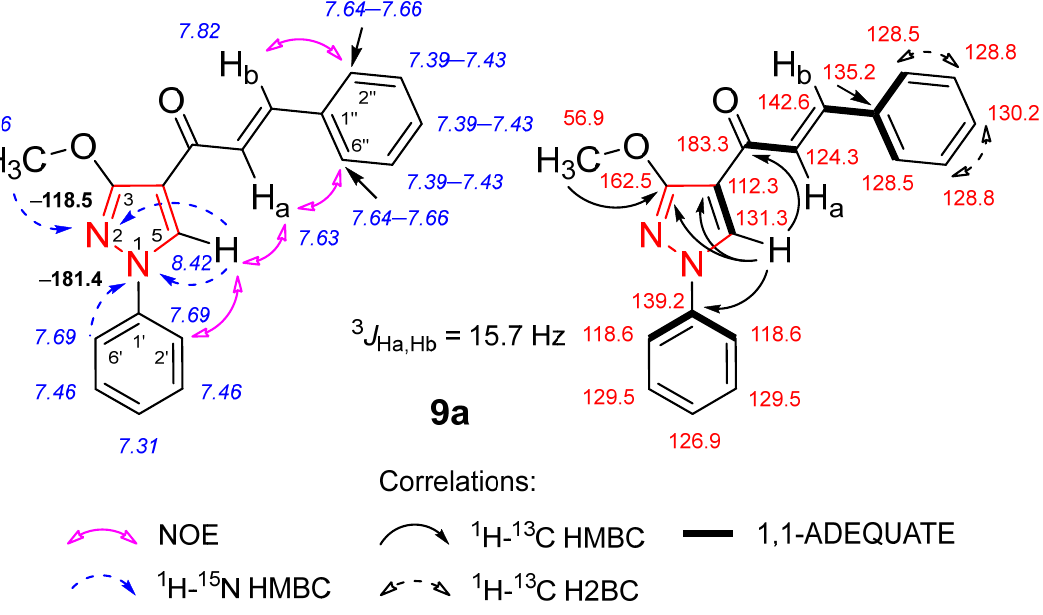
Figure 3. Relevant 1 H- 13 C HMBC, 1 H- 13 C H2BC, 1 H- 15 N HMBC, 1 H- 1 H NOESY and 1,1-ADEQUATE correlations and 1 H NMR (italics), 13 C NMR and 15 N NMR (bold) chemical shifts of compound 9a .